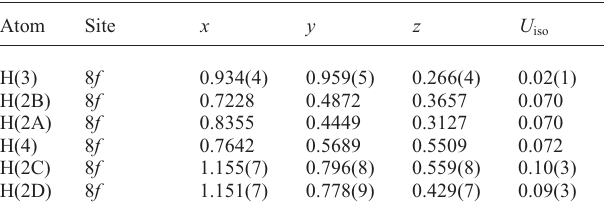
Table 2. Atomic coordinates and displacement parameters (in Å 2 )